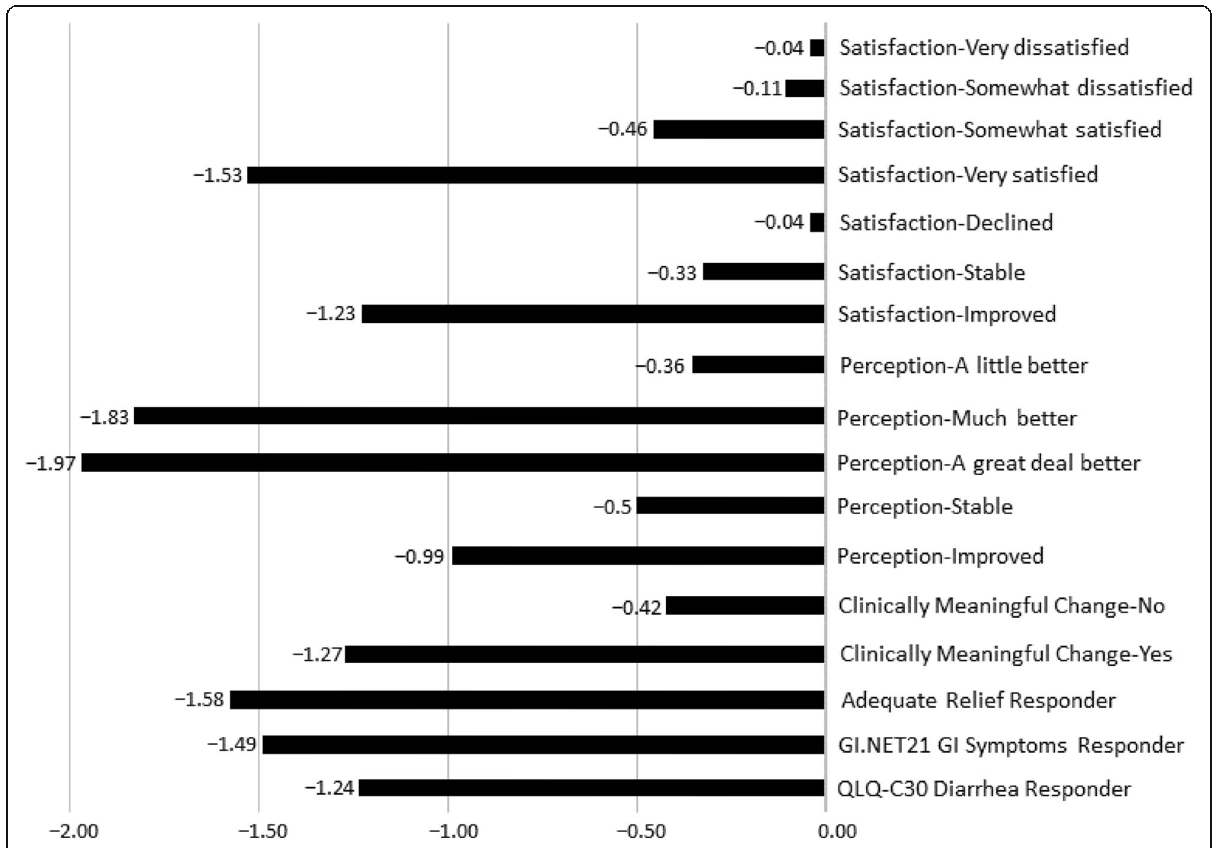
Fig. 2 Effect Sizes of Change in BM Frequency at Week 12 from Baseline (ISP population)